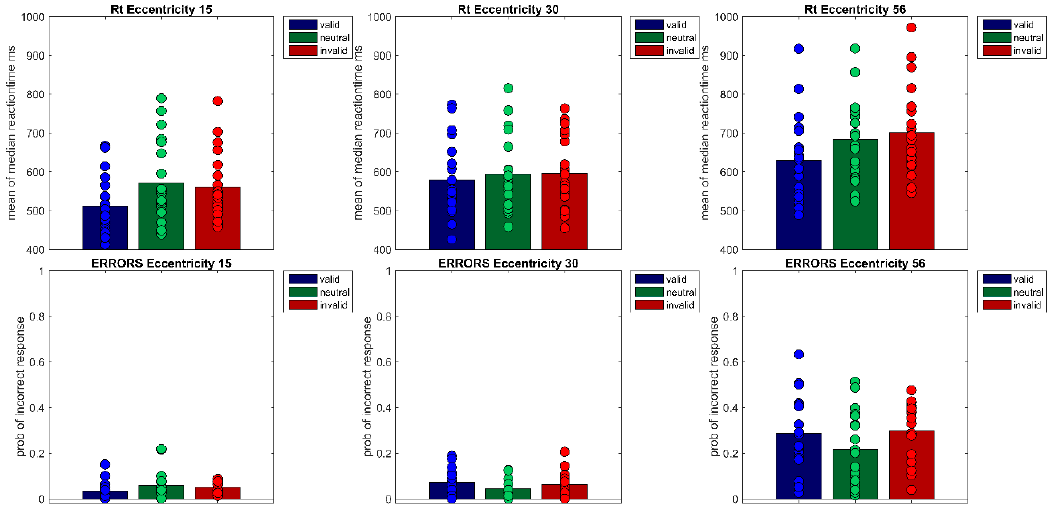
Figure 2. The figure shows the correct reaction times of Experiment 1 per Eccentricity (15°, 30°, 56°) × Cueing (valid, neutral, invalid). Bars show the mean of median reaction times across participants. Filled circles show the medians of each individual participant (upper row). The lower row shows the probabilities of incorrect responses for each of the nine conditions. Bars denote the mean probability across participants, filled circles the probabilities of each participant.